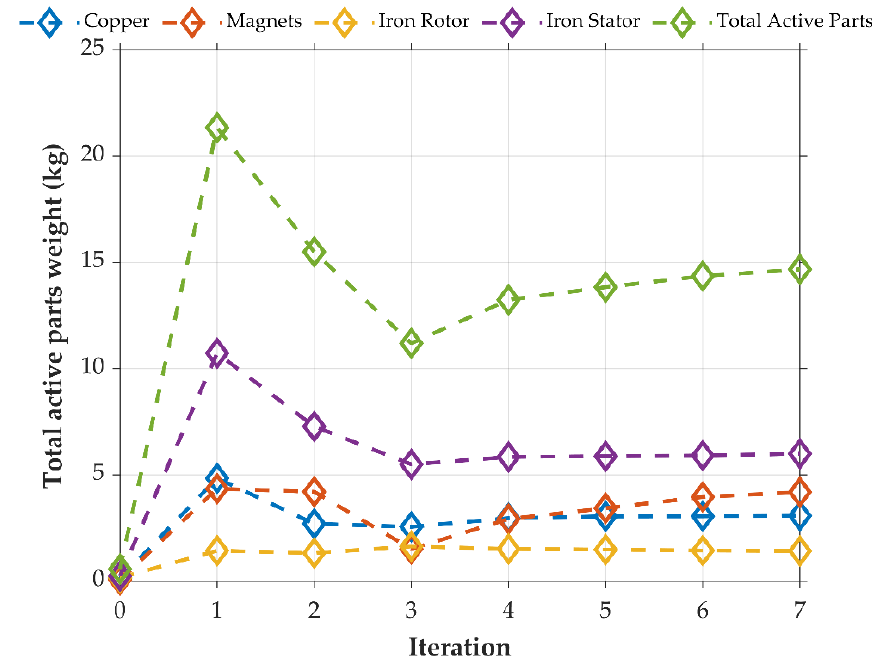
Figure 7. Optimal weight of active